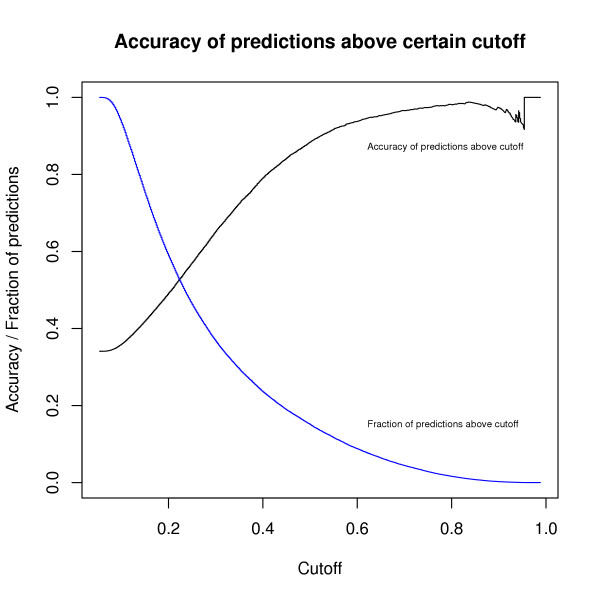
Classification accuracy, if all predictions below a given confidence threshold are discarded (RF classifier). High confidence parts of the plot mostly consist of predictions for the dominant class according to the predicted confidence ranges in figure 7.